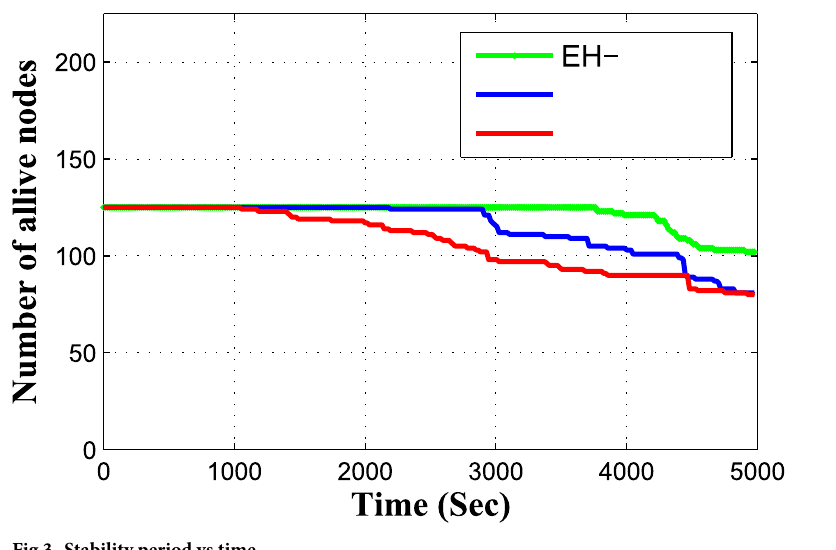
Fig 3. Stability period vs